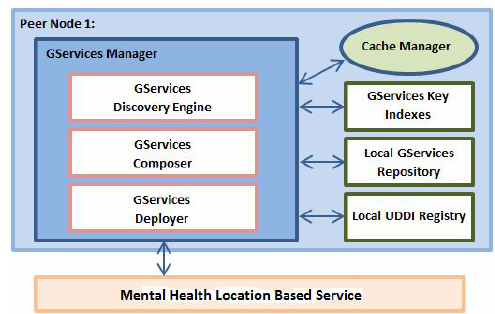
Figure 5. The internal architecture of a peer node and its connection with Mental Health